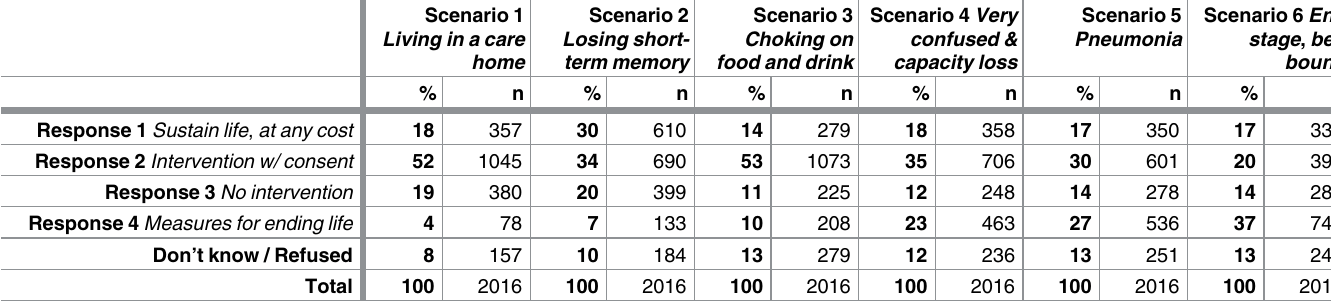
Table 2. Cross-tabulation illustrating total respondents’ answers across the six-stage vignette using weighted data (n =